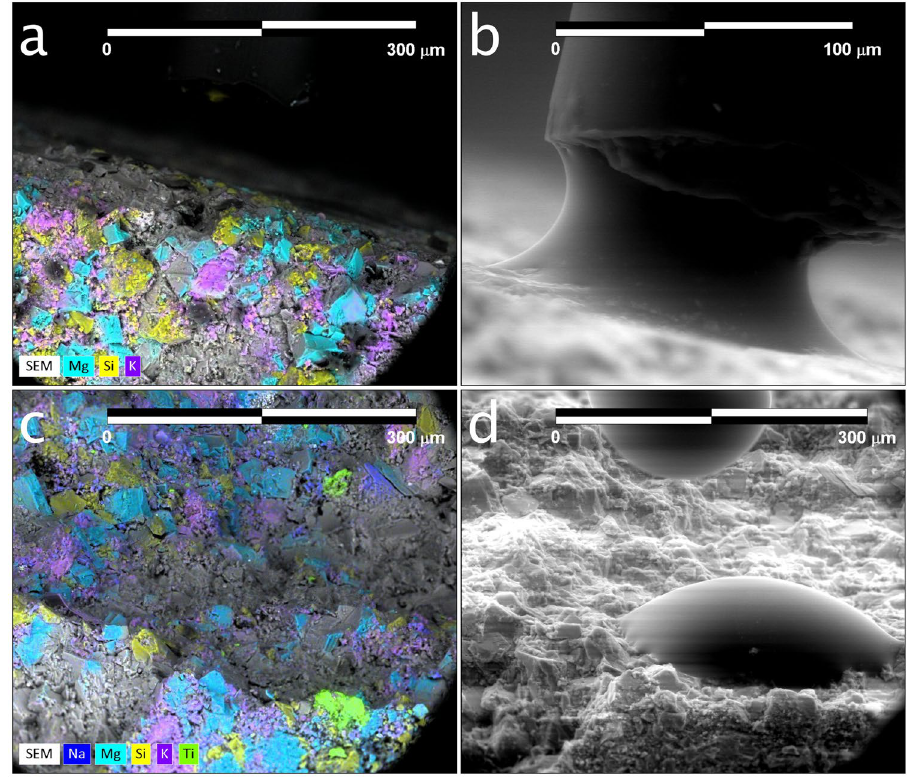
Figure 7. ( a ) Elemental map of the edge of a middle Bakken sample (Sample 1A) used for micro-injection analysis. This sample orientation is nearly orthogonal to the imaging plane, offering an ideal view of micro- droplet formation. ( b ) A secondary-electron image of water injected out of the silica tube (10 µ m ID, 150 µ m OD) onto Sample 1A during a micro-injection experiment. This image is a still taken from a sequence of time- lapse images used for evaluation of advancing and receding contact angles (not shown). ( c ) Elemental map taken of a less-ideally oriented Bakken sample (Sample 1B) used for micro-injection analysis. ( d ) A secondary electron image of sessile droplet formation on Sample 1B during a micro-injection experiment. This image is a still taken from a sequence of time-lapse images (Fig. 8) used for evaluation of micro-droplet contact angles during water